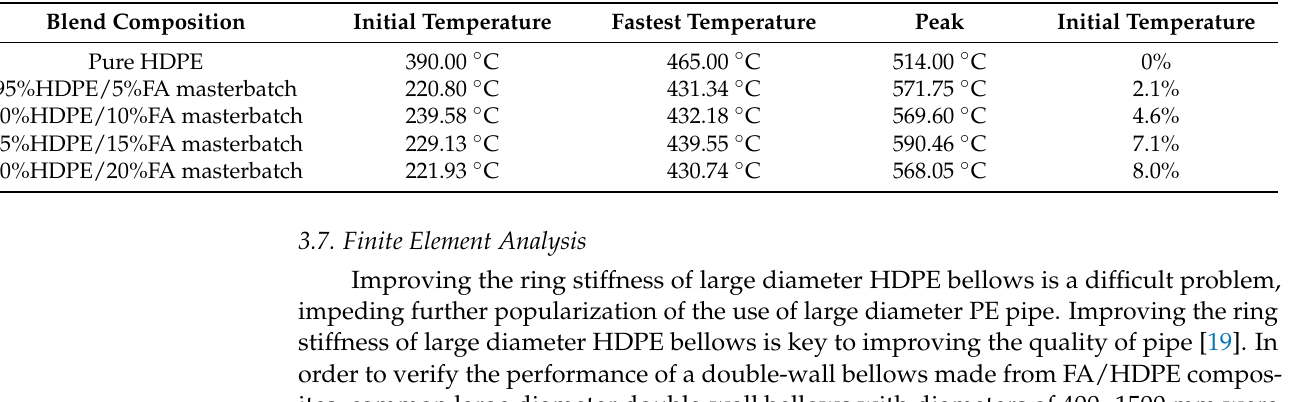
Table 5. Thermogravimetric Analysis of FA/HDPE Composites.